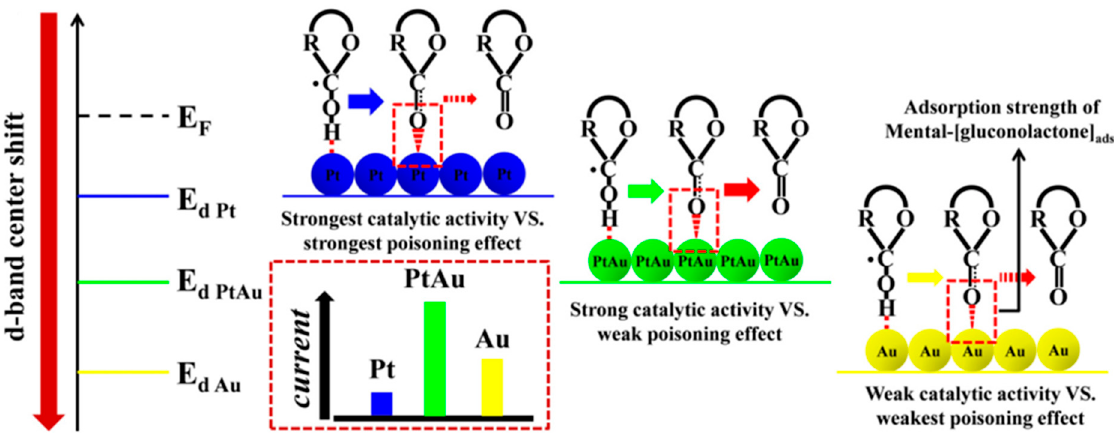
Figure 12. Schematic diagram of glucose electro-oxidation on the Pt, Pt-Au, and Au catalysis surfaces as a function of the d -band center position. (Reproduced with permission from [229]. Copyright Elsevier, 2020).